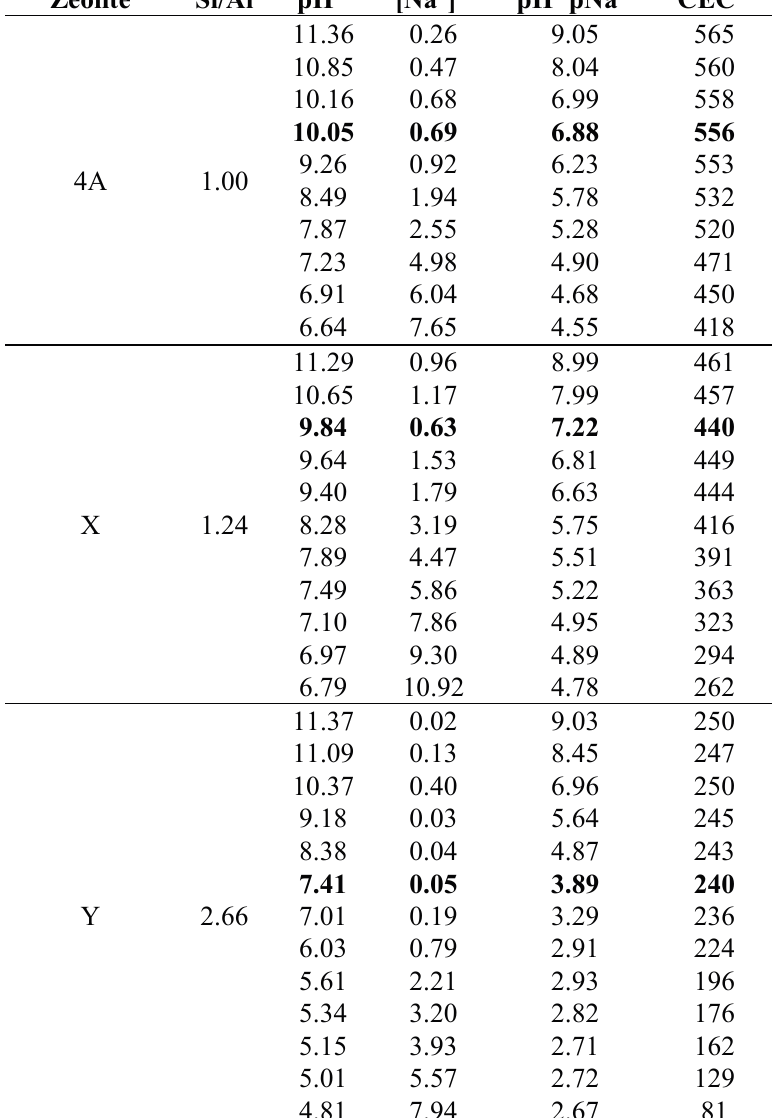
Table 1. pH and Na + concentration at equilibrium, pH − pNa and CEC of